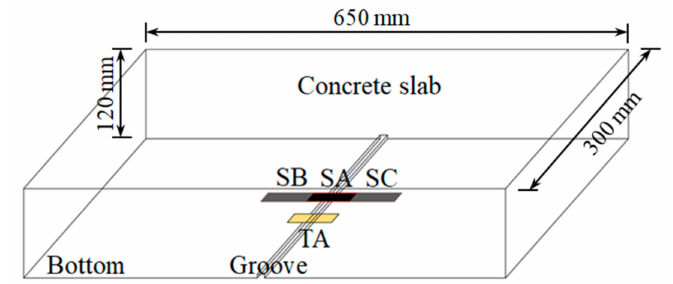
Figure 9. The positions of the film sensor and resistance strain gauge.